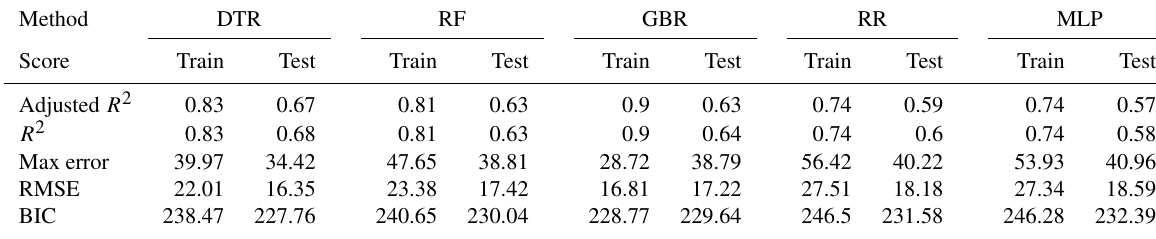
Table A7. Training and test scores on annual basis for the general population with demographic features turned off. Method